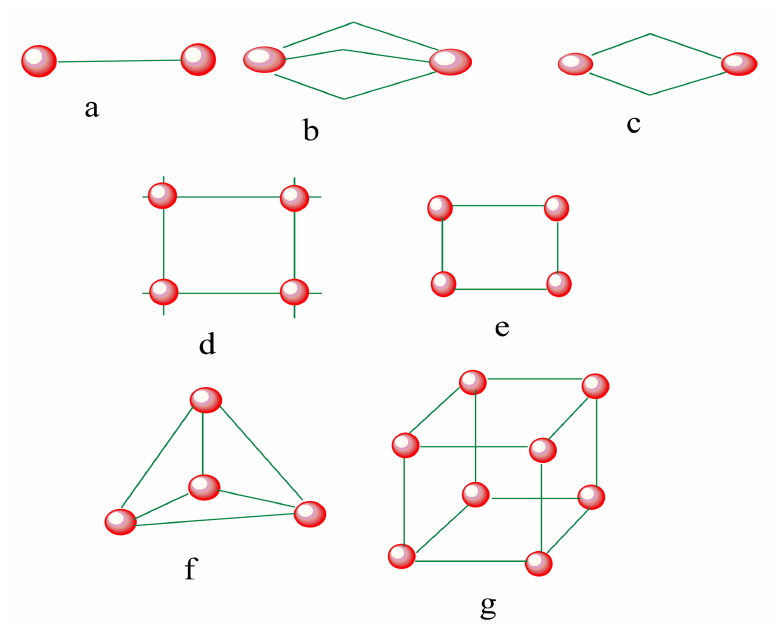
Figure 3. SCO-active complexes of di-nuclear ( a – c ); grid ( d ), square ( e ), tetrahedral cage ( f ), octahedral cube ( g ). Green = di- to polydentate of N-donor and O-donor Schiff base ligands. Red = iron (II) metal